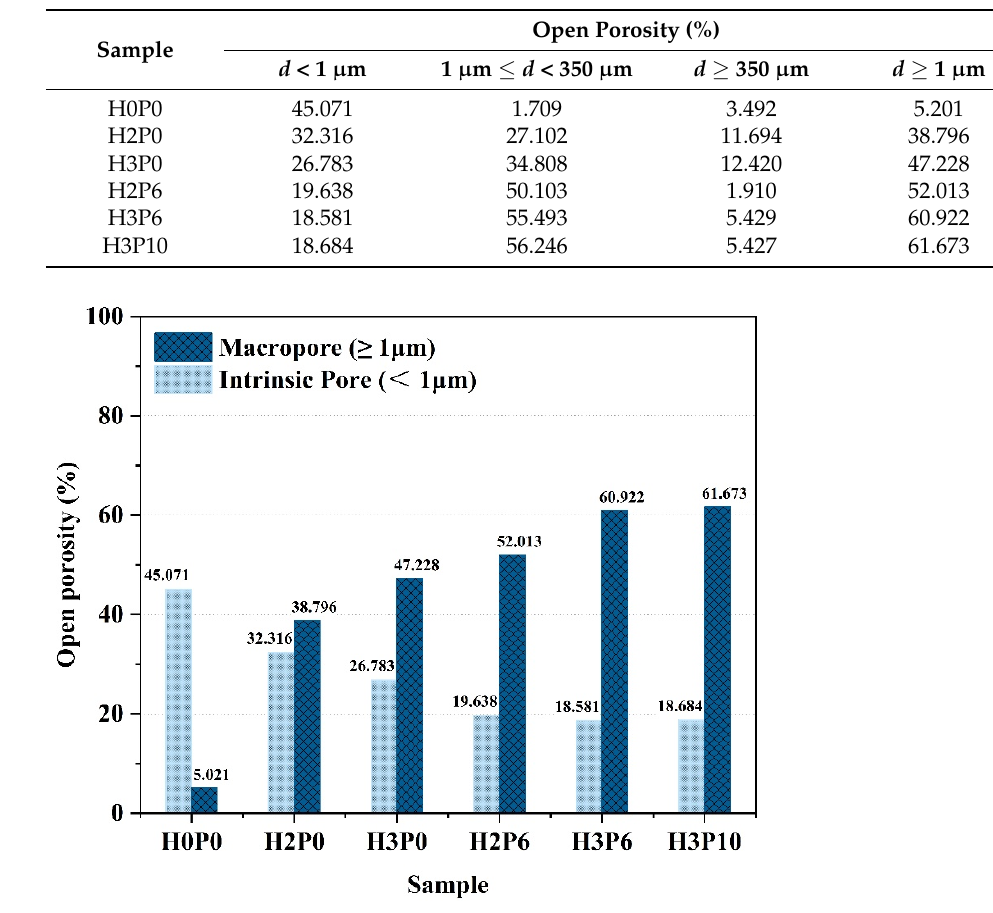
Figure 11. Graded open porosity of matrix and geopolymer